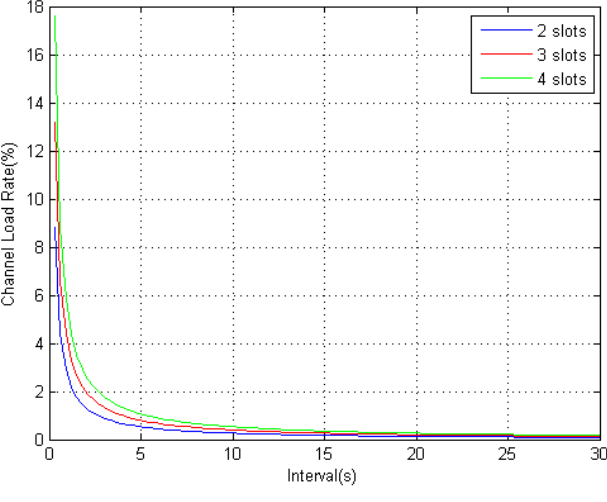
Figure 4. Channel load rate when using broadcast binary